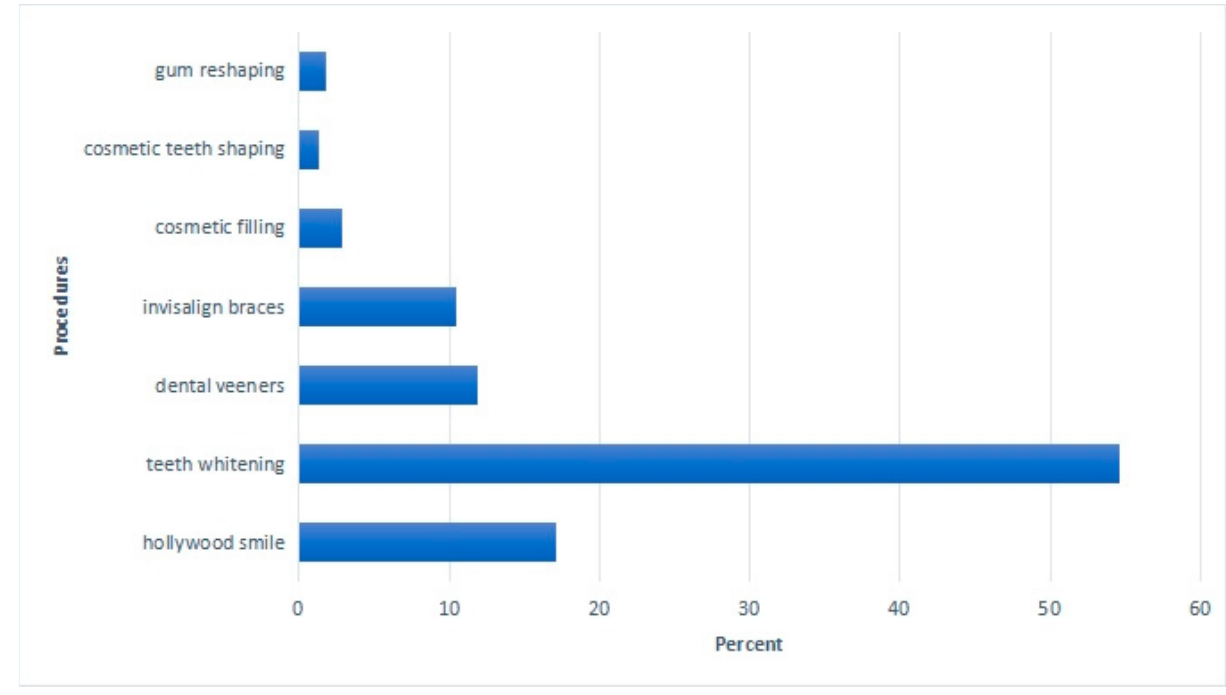
Figure 3. Aesthetic dental procedures most commonly demanded by